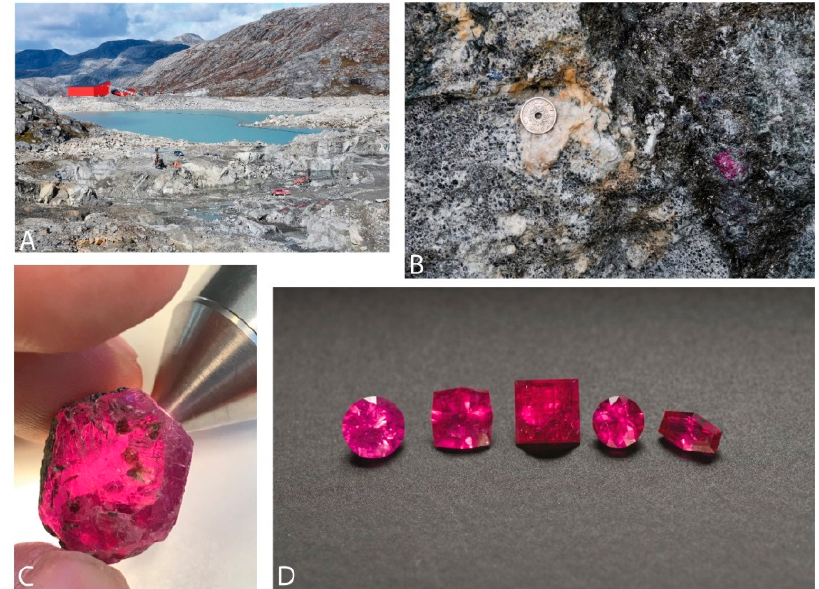
Figure 43. ( A ) The ruby mine at Aappaluttoq. Photo: Vincent Pardieu; ( B ) gem corundum in outcrop. Photo: Vincent Pardieu; ( C ) ruby rough. Photo: Vincent Pardieu; ( D ) a selection of cut gems (0.5–0.75 ct) from the Greenland deposits [34], courtesy of True North Gem Inc.